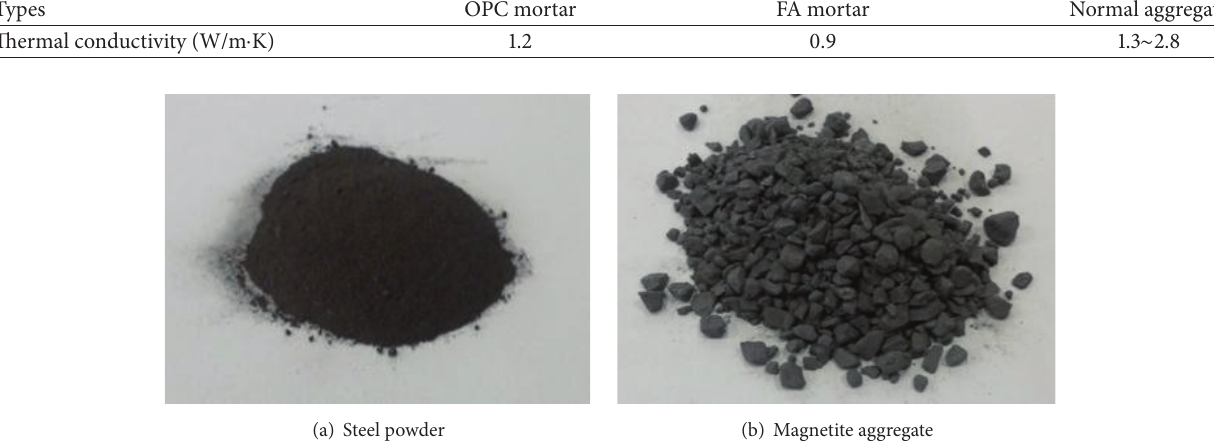
Figure 3: Photos of SP and MA.